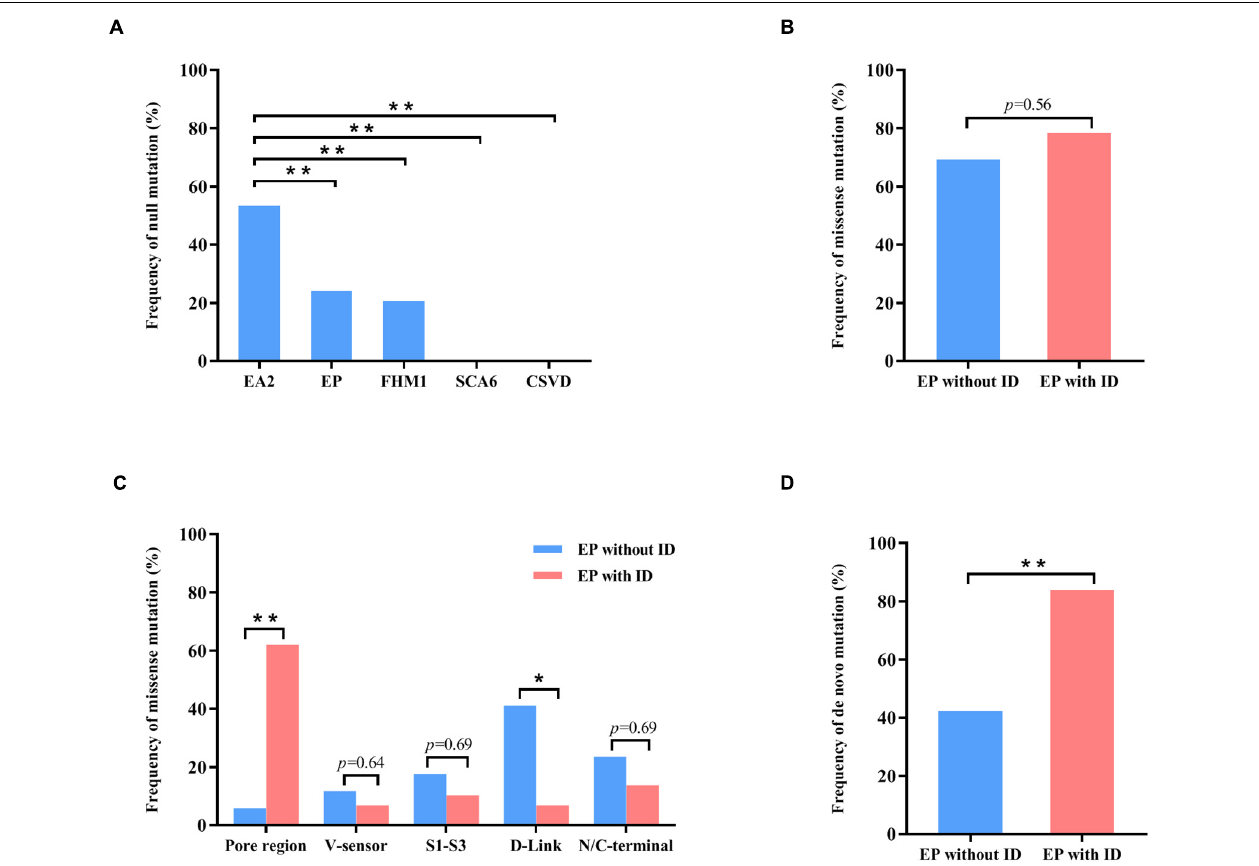
FIGURE 4 | Genotype–phenotype correlations of CACNA1A mutations. (A) The frequency of null mutations in CACNA1A for each phenotype. The values are expressed as the percentage of cases with null mutations (cases with null mutations/total cases) in each group. (B) The frequency of null mutations in CACNA1A for epilepsy without intellectual disability and epilepsy with intellectual disability. (C) The frequency of missense mutants in various regions of the Cav2.1 channel for epilepsy and epilepsy with intellectual disability. (D) The frequency of de novo mutations in CACNA1A for epilepsy and epilepsy with intellectual disability. Fisher’s exact test was used for statistical analysis of the differences between each group. CSVD, cerebral small vessel disease ( n = 18). EA2, episodic ataxia 2 ( n = 155). EP, epilepsy ( n = 63). EP without ID, epilepsy without intellectual disability ( n = 26). EP with ID, epilepsy with intellectual disability ( n = 37). FHM1, familial hemiplegic migraine 1 ( n = 53). SCA6, spinocerebellar ataxia 6 ( n = 7). * P < 0.05; ** P <